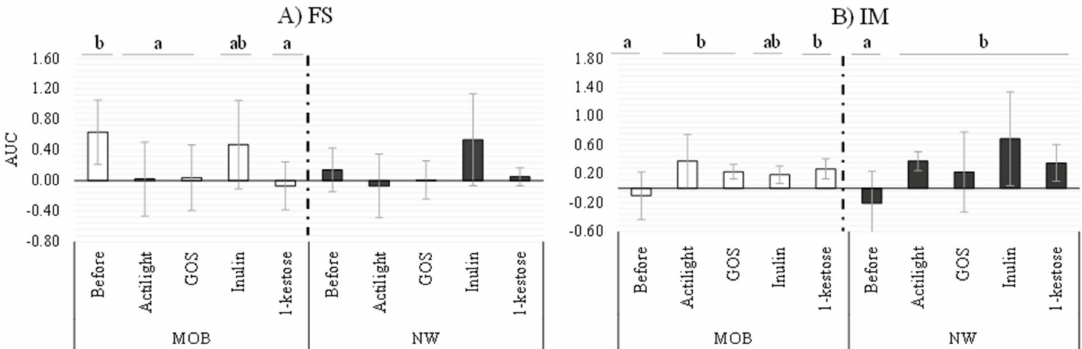
Figure 4. Real-time monitoring the interaction between ( A ) fecal supernatants and ( B ) isolated microbiota obtained before and after incubation with prebiotics and HT29 intestinal epithelial cells. Values (media ± SD) correspond to the Area Under the Curve (AUC) resulting from monitoring the cell index (CI) during 10 h. Significant di ff erences ( p -value < 0.05) represent the comparison of